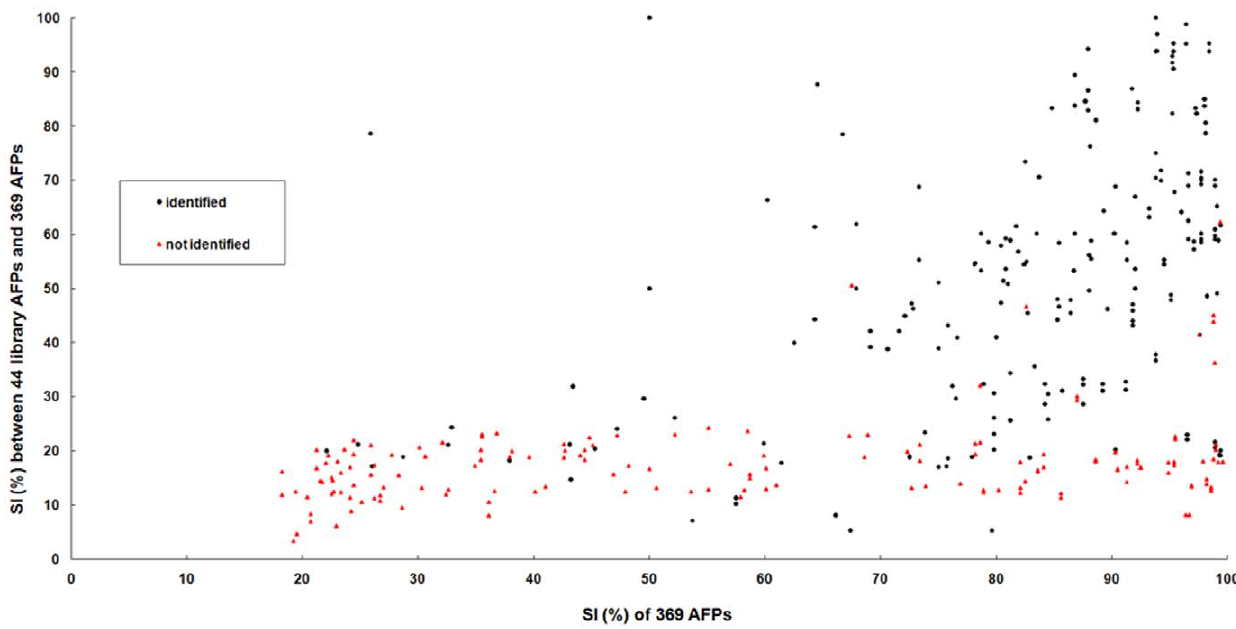
Figure 1. Sequence identity distribution for pairs of AFPs. The x- axis values are the best pairwise-matched SI values for each AFP sequence against the other 368 sequences. The y -axis values are the best pairwise-matched SI values for each of the 369 AFP sequences of the second independent dataset against the 44 sequences of the validation set. Whether an AFP is identified (black symbol) or not identified (red symbol) in the independent data is indicated.